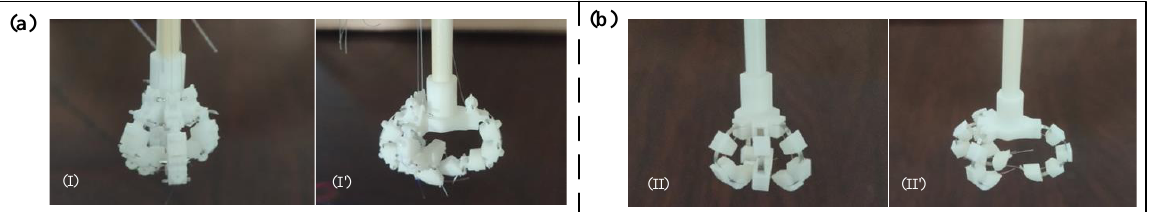
Figure 8. Results of two perch gripping mechanisms with claw toes reaching maximum bending. ( a ) Articulated. (I) Front view, ( I’ ) side view. ( b ) Resilient reset type. (II) Front view, ( II’ ) side view.